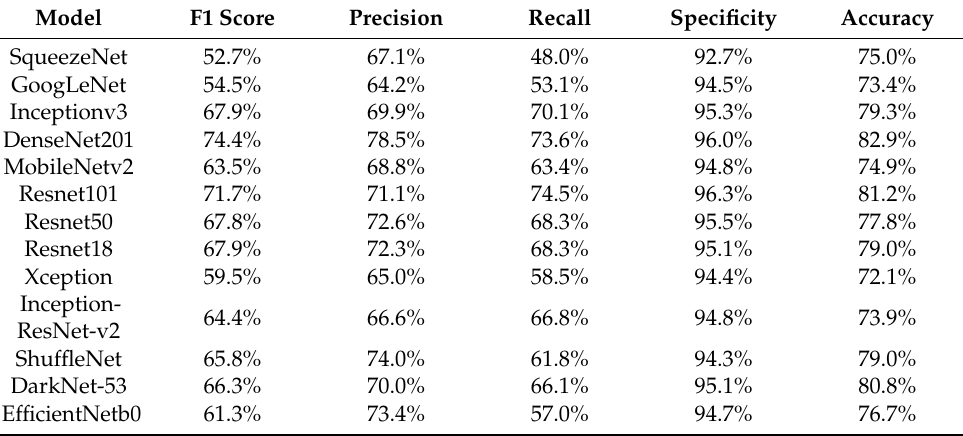
Table 3. The mean overall accuracy, F-score, precision, recall, and specificity for each deep learning model and 90/10 data